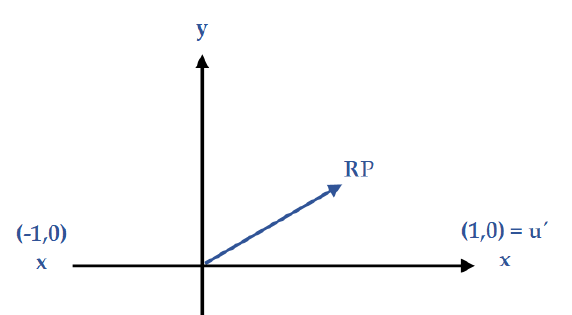
Figure 4. A simple method for calculating u (cid:48) that has been used for defining the points of the half-planes. In this special case, the moving direction of the group considers in Y